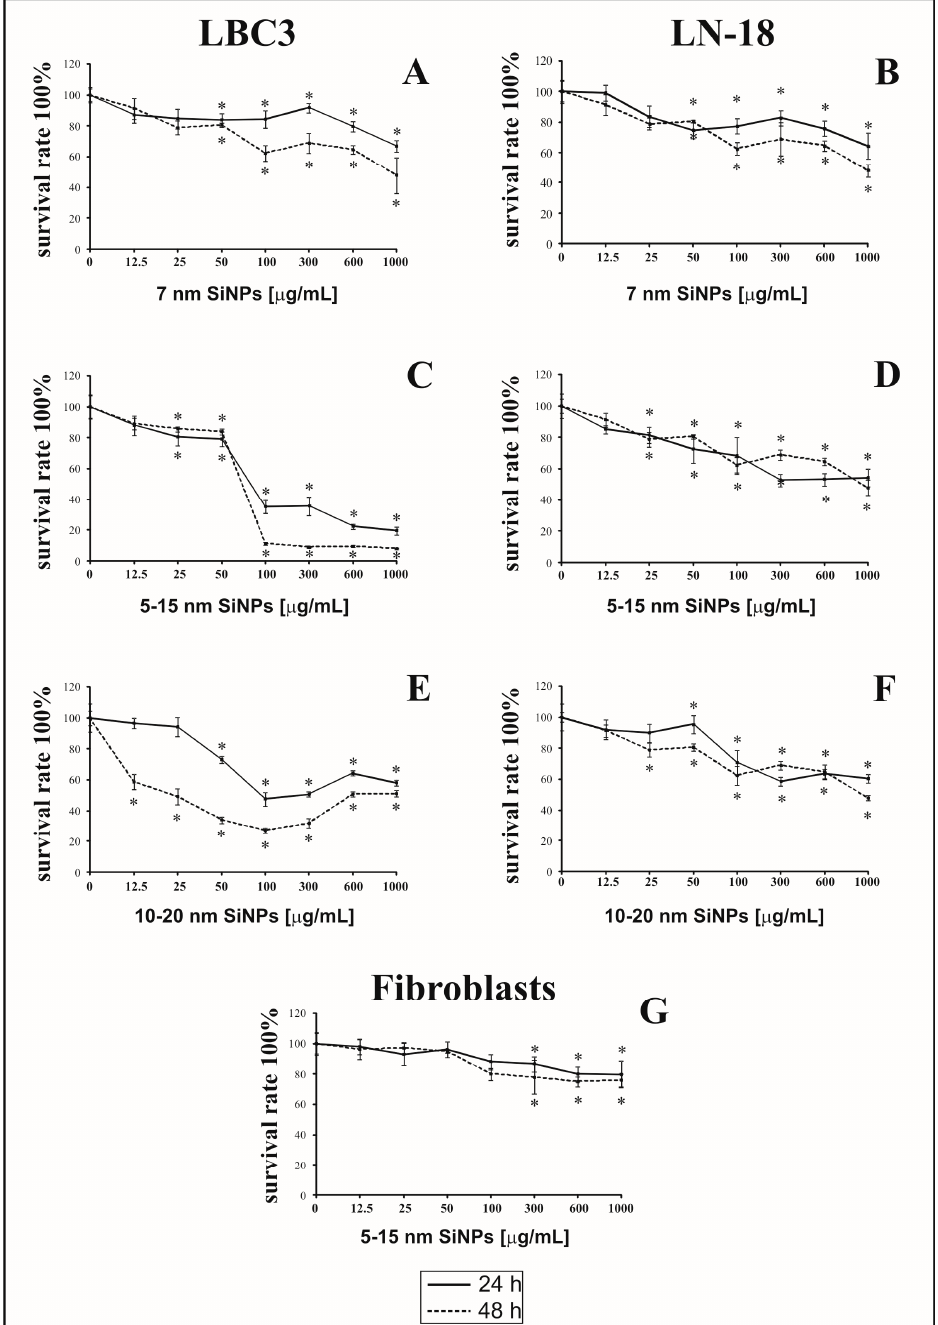
Figure 1 . The viability of LBC3 ( A , C , E ) and LN-18 ( B , D , F ) cells treated with different concentrations (12.5 to 1000 μ g/mL) of SiNPs in three different sizes: 7 nm ( A , B ), 5–15 nm ( C , D ) and 10–20 nm ( E , F ), for 24 and 48 h. Graph ( G ) presents the viability of human skin fibroblasts incubated with different concentrations, from 12.5 to 1000 μ g/mL, of 5–15 nm SiNPs, for 24 and 48 h. Mean values from three independent experiments ± SD are presented. Significant alterations are expressed relative to controls and marked with asterisks. Statistical significance was considered if * p < 0.05.